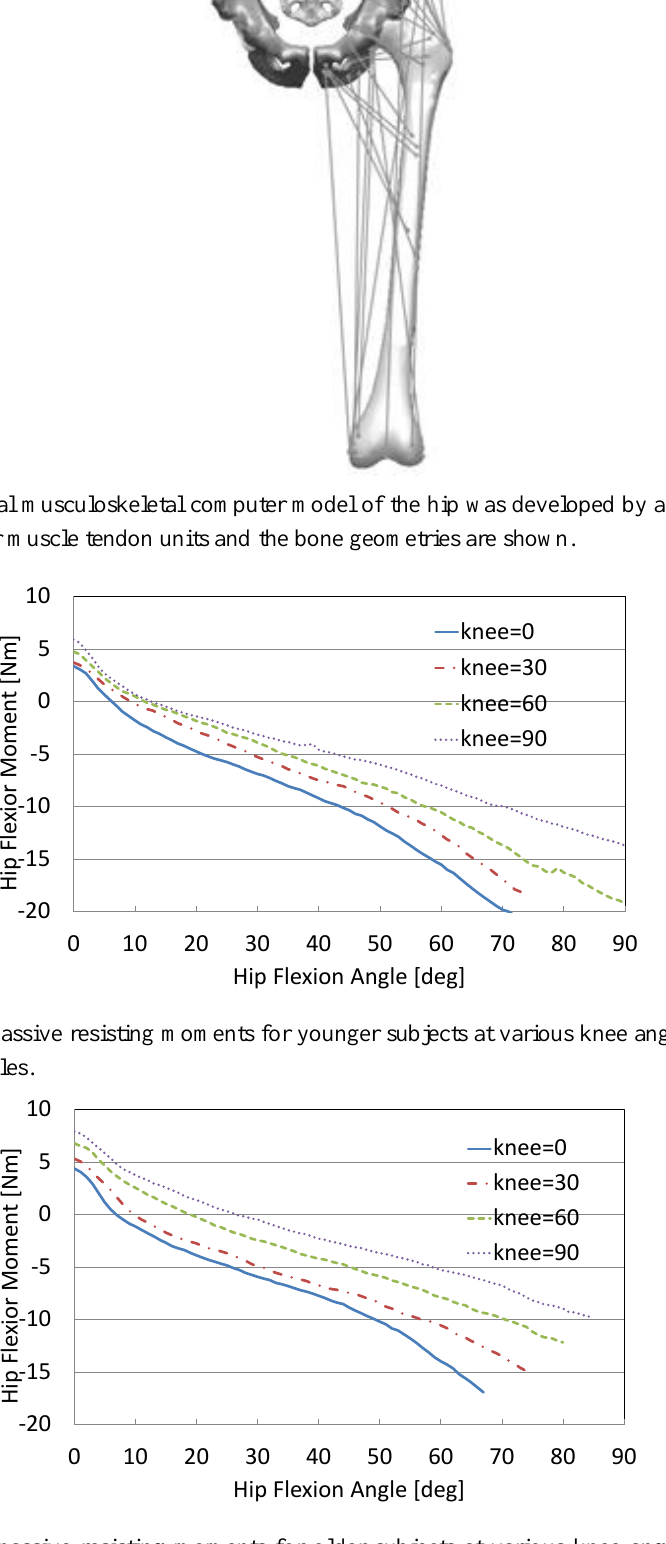
Figure 4 Mean values of passive resisting moments for older subjects at various knee angle positions are plotted against the hip flexion angles.